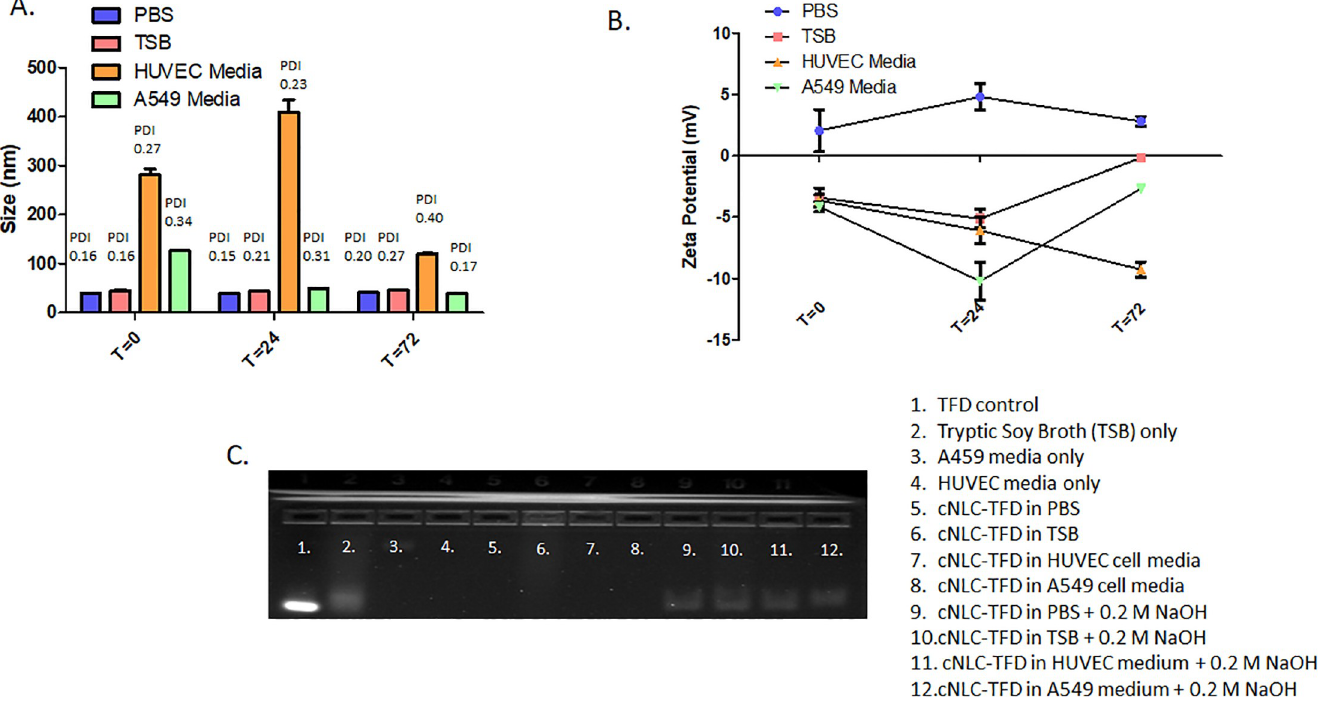
Fig 3. Stability analysis of cNLC-TFD nanocomplexes at N/P = 32 over a 72-hour timeframe in a variety of biological buffers. A) Size and polydispersity analysis B) zeta potential analysis C) agarose gel electrophoresis analysis of nanocomplex integrity following incubation at 37˚C for 72 hours.